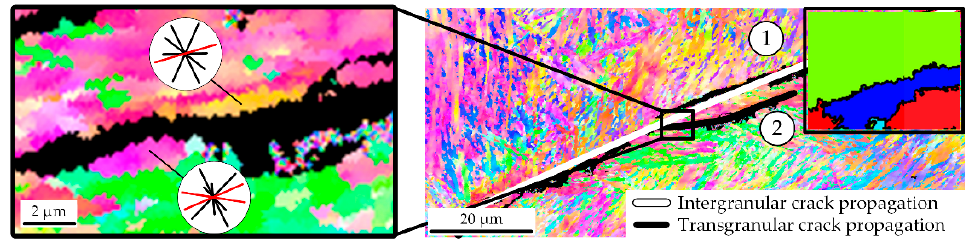
Figure 12. EBSD analysis with calculated {110} glide plane traces (active glide traces marked in red) and reconstructed prior austenite grain boundaries of an SP sample loaded at Δσ /2 = 630 MPa for and reconstructed prior austenite grain boundaries of an SP sample loaded at ∆ σ /2 = 630 MPa for 1,000,000 cycles. The numbers in the EBSD analysis mark the breakpoints of the crack. 1,000,000 cycles. The numbers in the EBSD analysis mark the breakpoints of the